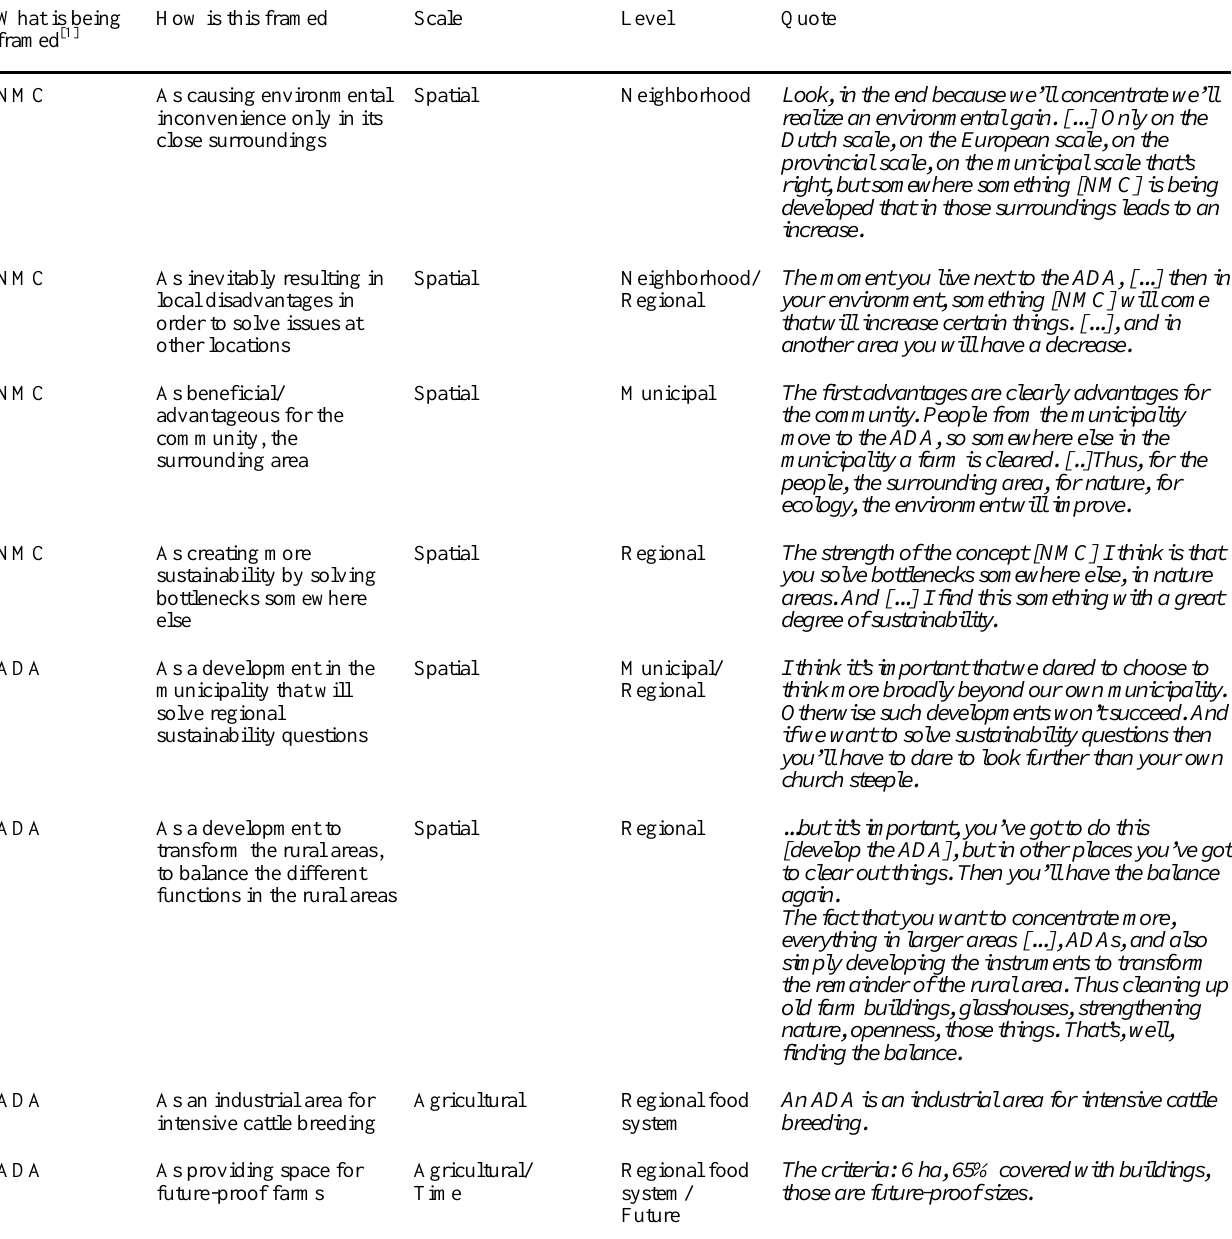
Table 2. The scales and levels used by the